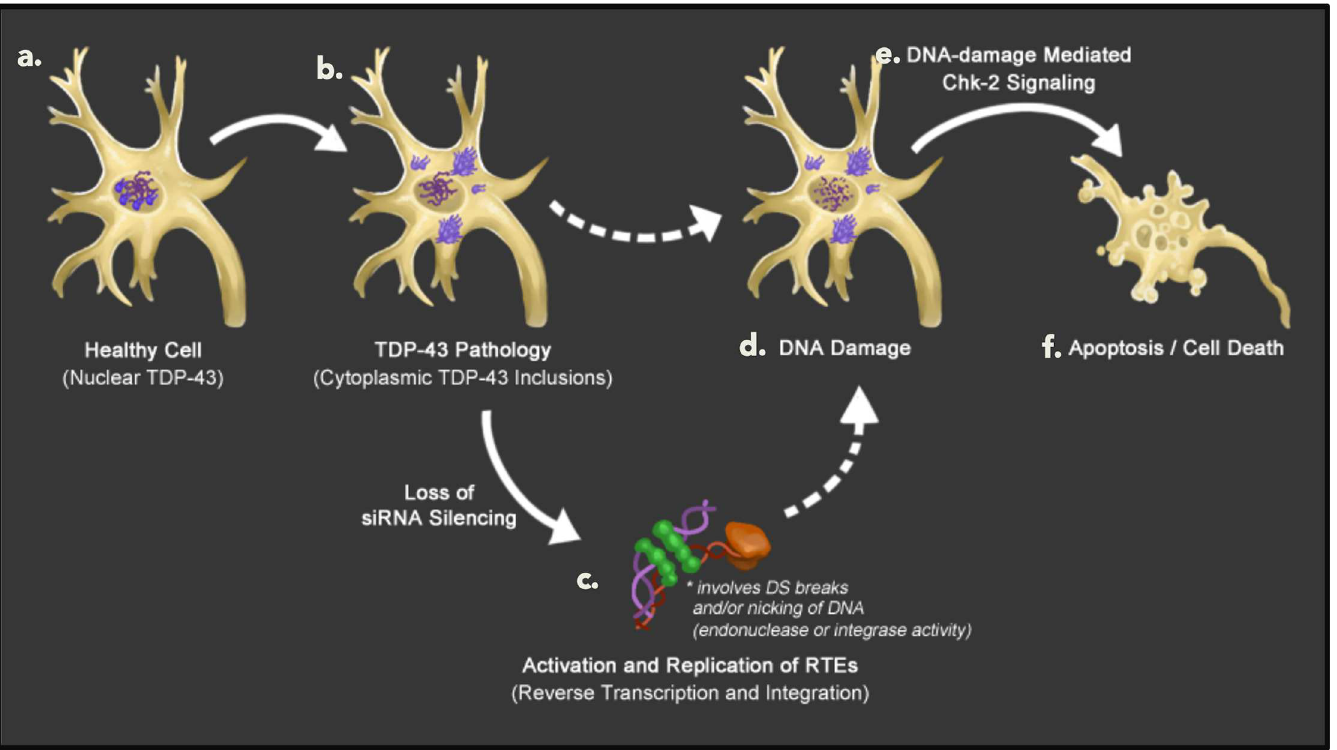
Fig 7. A cellular model for RTE mediated DNA damage and apoptotic cell death in TDP-43 pathology. In a healthycell TDP-43 protein is predominantly found in the nucleus with the capacityto shuttle betweenthe nucleusand the cytoplasm. This pleiotropicprotein plays many important roles in normal RNA metabolismin both cellularcompartments (A). Cells that experience TDP-43 pathologyexhibitaccumulationof TDP-43 protein in dense cytoplasmic inclusionsand clearance from the nucleus(B). This is accompaniedby rapid deterioration of siRNA-mediatedsilencing,as well as activationof RTE expression(C). The apoptotic cell death (F) inducedby TDP-43 pathology is largely mediatedby Loki/Chk-2 signaling(E). In the case of hTDP-43 pathology in fly glial cells in the CNS, expressionof the gypsy RTE contributes to hTDP-43-inducedcell death. Based on this observation, as well as the known cell biological role of Loki/Chk-2,we infer that the apoptosisinducedby TDP-43 pathologyis largely the result of Chk-2 activationin responseto TDP- 43-induced DNA damage (D), and that this DNA damage is at least partially incurred by TDP-43’s effects on RTEs